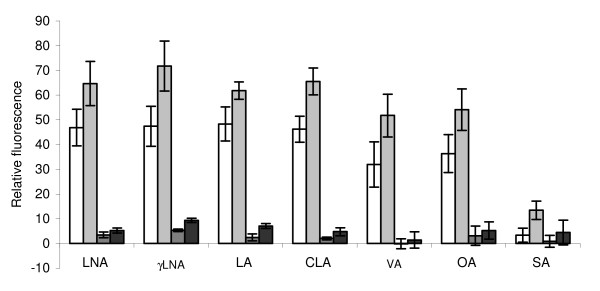
Influence of different fatty acids and fatty acid methyl esters on cell integrity of B. fibrisolvens JW11. Loss of cell integrity was determined fluorimetrically by propidium iodide fluorescence. LNA, cis-9, cis-12, cis-15-18:3; γLNA, cis-6, cis-9, cis-12-18:3; LA, cis-9, cis-12-18:2; CLA, a mixture of cis-9, trans-11-18:2 and trans-10, cis-12-18:2; VA, trans-11-18:1; OA, cis-9-18:1; SA, 18:0. In order of increasing shading density: 50 μg fatty acid ml-1, 200 μg fatty acid ml-1, 50 μg fatty acid methyl ester ml-1, 200 μg fatty acid methyl ester ml-1. Results are means and SD from three determinations.